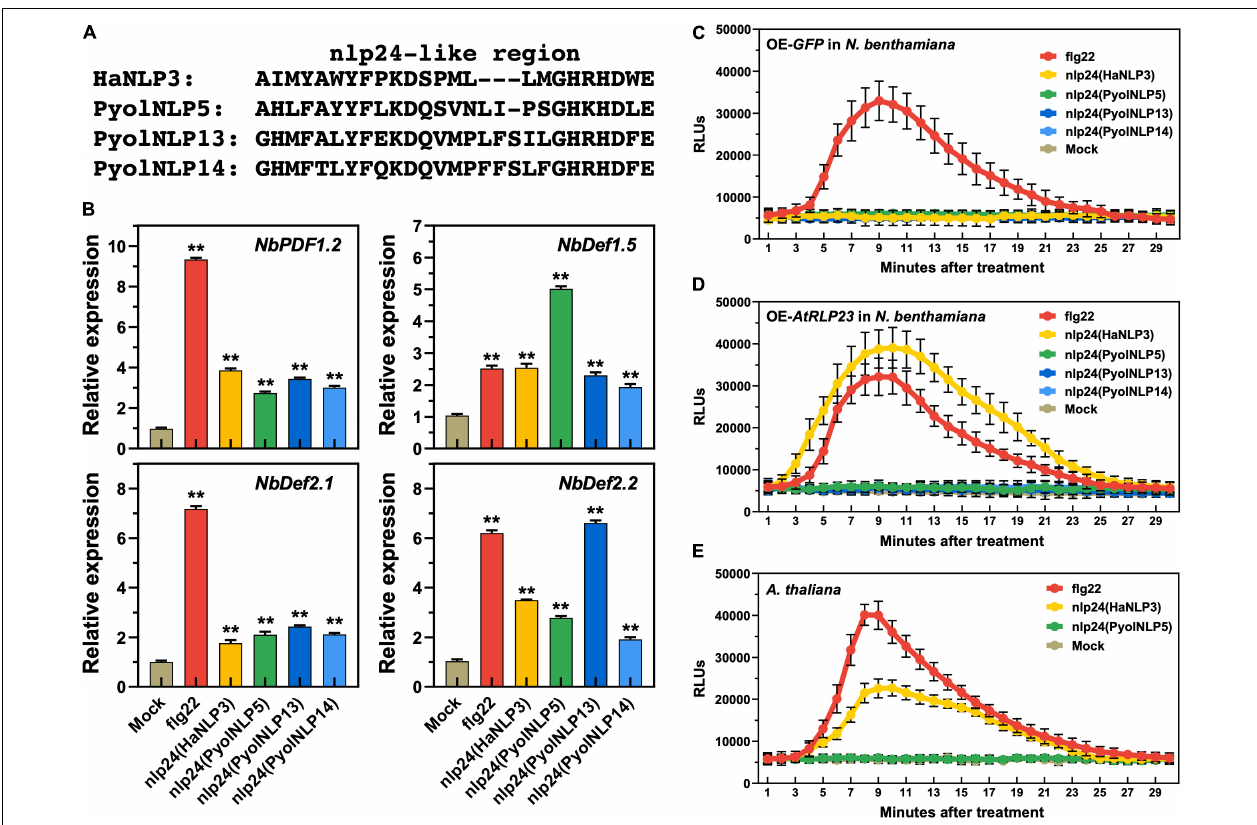
FIGURE 7 | Plant defensin expression induced by Pyolnlp24-Like Pattern is irrelevant to the classic nlp24 receptor RLP23. (A) Schematic representation of nlp24 in HapNLP3 and nlp24-like regions in PyolNLP5, PyolNLP13 and PyolNLP14. (B) Relative expression levels of plant defensin genes in N. benthamiana leaves infiltrated with classic nlp24 (HaNLP3 from Hyaloperonospora parasitica ) or Pyolnlp24-like pattern from PyolNLP5, PyolNLP13 or PyolNLP14. ddH 2 O and flg22 were used as negative and positive controls, respectively. Transcription levels of plant defensin genes NbPDF1.2 , NbDef1.5 , NbDef2.1 and NbDef2.2 were determined by qRT-PCR using EF1 α as reference. Error bar represents mean ± SD ( n = 3). Data were analyzed by Median-edition Levene’s test to determine the homogeneity of variance across groups, and then analyzed by one-way ANOVA with post-hoc Tukey’s range test for groups with equal variance (** P < 0.01). (C,D) Dynamics of ROS burst triggered by nlp24 of HaNLP3 in N. benthamiana expressing AtRLP23. (E) Dynamics of ROS burst triggered by nlp24 of HaNLP3 in Arabidopsis thaliana . Leaf disks were treated with water, 500 nM flg22 or nlp24 for 30 min before the detection of relative luminescence units (RLUs) (mean ± SEM, n = 6). All experiments were repeated at least three